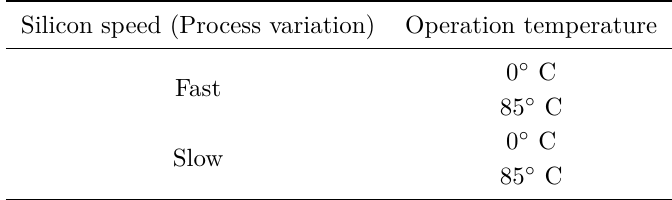
Table 2: STA corner timing-models available in the Quartus STA from fastest to slowest model for a given device speed grade at 1100 mV supply